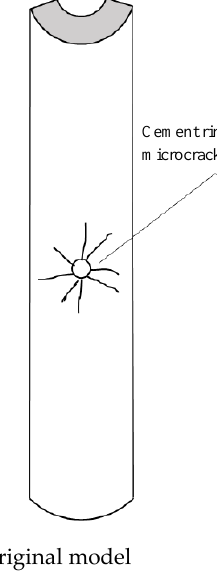
Figure 1. Schematic diagram of cracks close to the perforation hole in cement sheath.